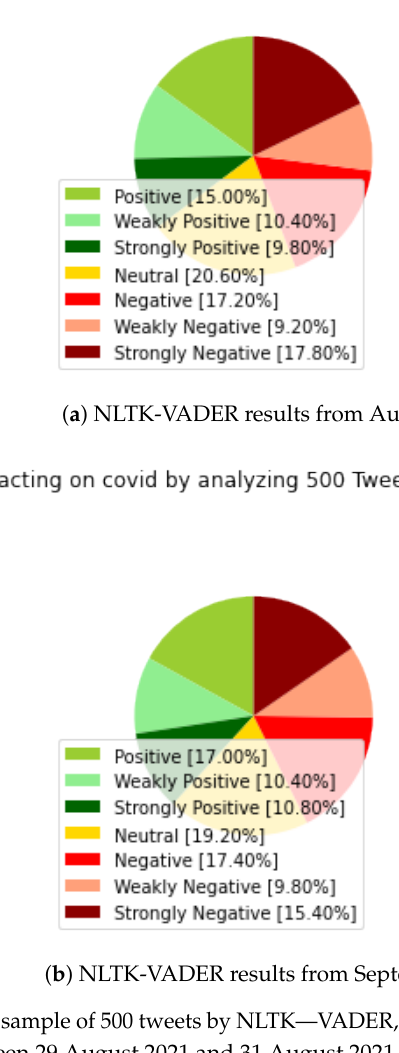
Figure 3. Analysis of sample of 500 tweets by NLTK—VADER, using the keyword ‘COVID’. The time periods stands between 29 August 2021 and 31 August 2021, and 2 September 2021 and 4 Septem- ber